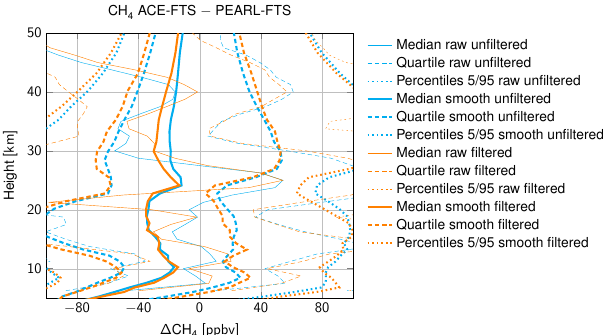
Figure 10. Distribution of the difference between profiles for ACE- FTS–PEARL-FTS. Solid, dashed, and dotted lines show the distri- bution of the difference as a function of altitude, similar to how they show the distribution of methane in Fig. 9. The blue lines show the differences for all profiles (labelled “unfiltered”), whereas the orange lines show the differences only for those profiles where (cid:49) sPV θ = 700K ≤ 0 . 2 × 10 − 4 s − 1 , where sPV θ = 700K is the scaled potential vorticity at a height corresponding to a potential tempera- ture θ of 700K along the line of sight, labelled “filtered”. See text for